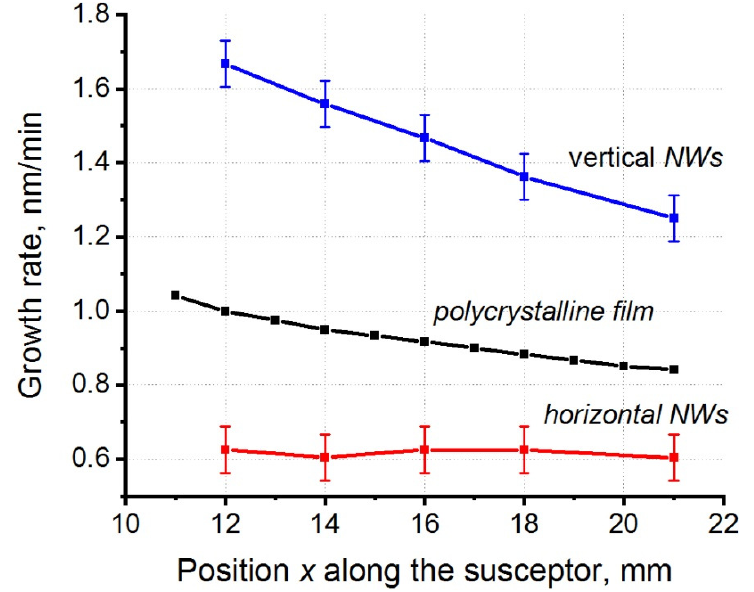
Figure 6. The growth rate of the VO 2 NWs and a polycrystalline VO 2 film as obtained by dividing the NW height by the synthesis time versus the location of NWs relative to the substrate holder edge. The gas flow is directed from left to right.